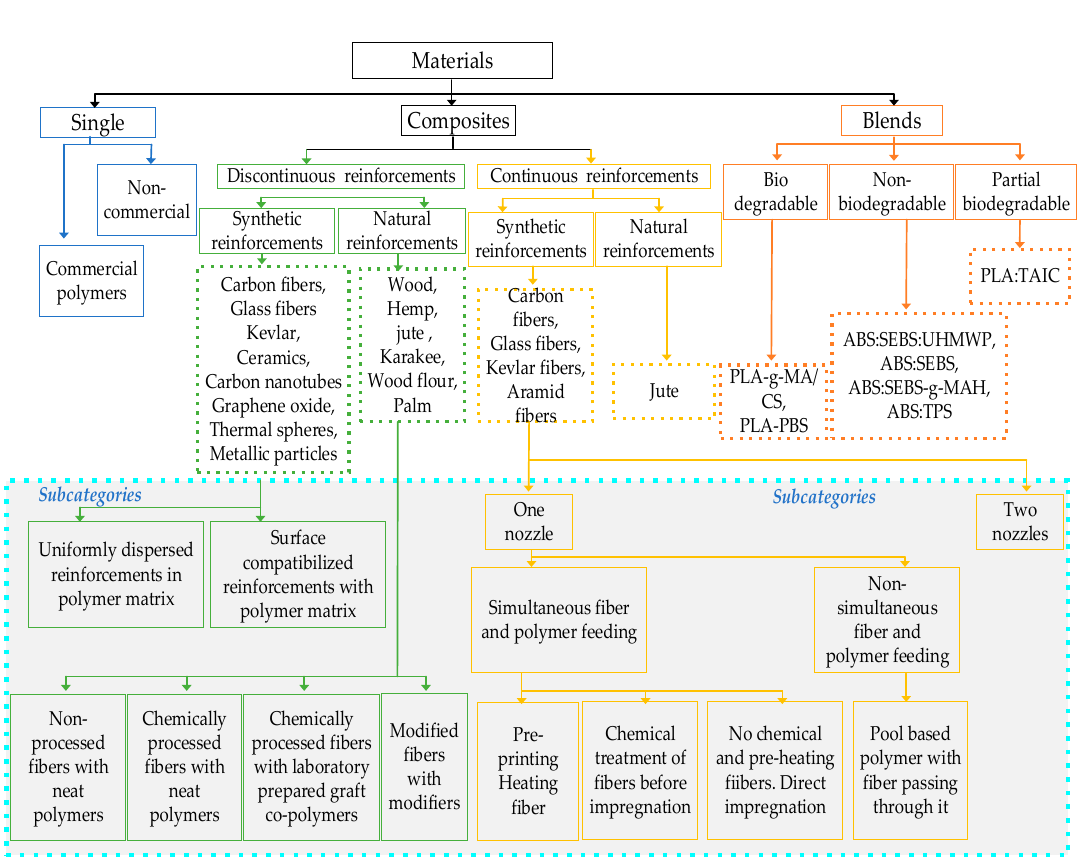
Figure 2. Materials for fused filament fabrication.